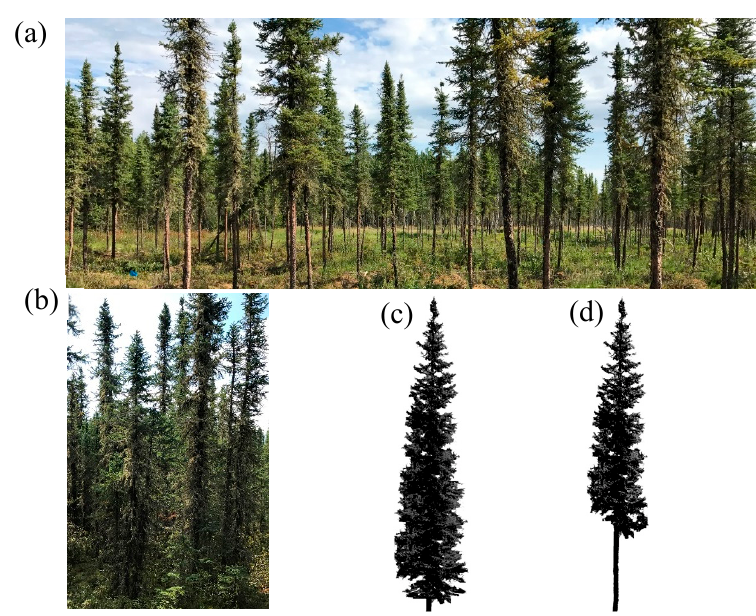
Figure2. FueltreatmentinblackspruceatthePelicanMountainresearchsite, Alberta. Counterclockwise from top left: ( a ) post-treatment stand structure; ( b ) natural stand structure; ( c ) natural and ( d ) pruned black spruce crown morphological structure. Documented maximum tree heights for black spruce at the Pelican Mountain research site ranged from 11 to 13 m